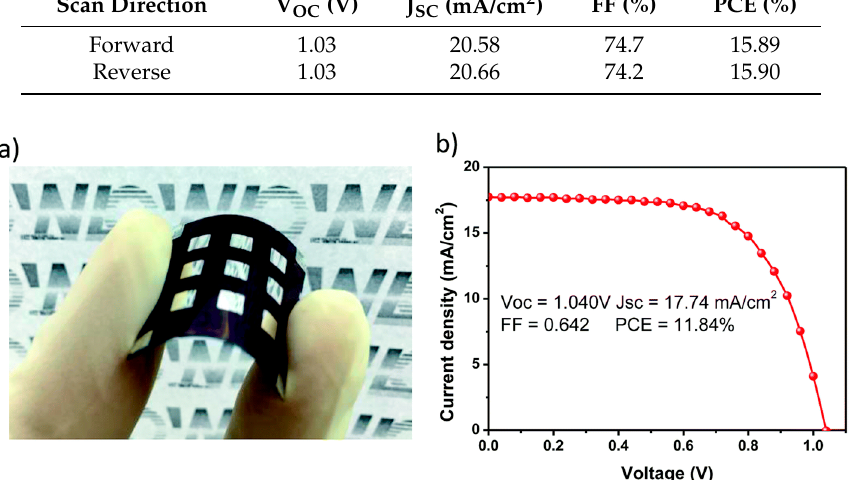
Table 3. Device performance of the NiO x -based inverted planar PSC measured under simulated Air Mass (AM) 1.5 conditions [143].